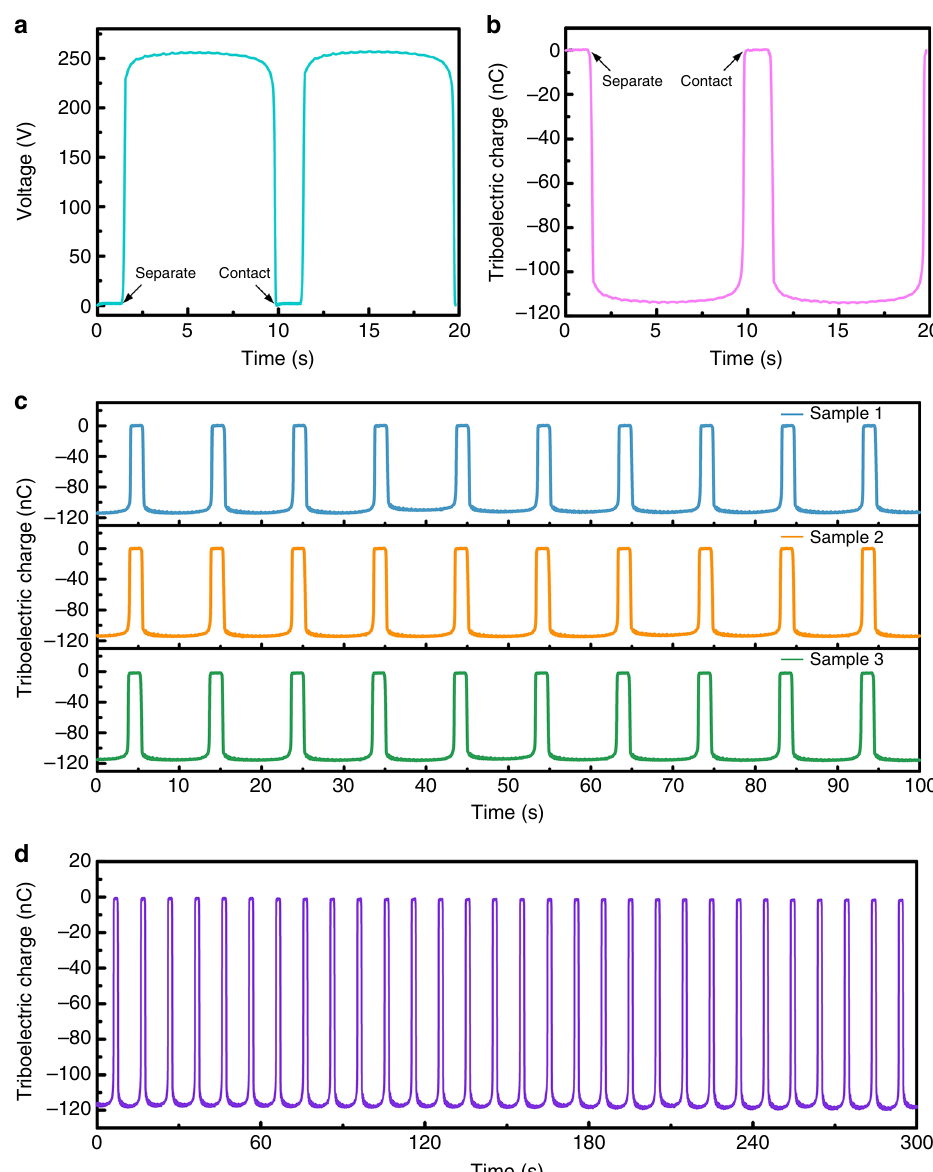
Fig. 3 Typical measured signals. a A typical output of open-circuit voltage in two cycles of contact and separation. b Short-circuit transferred charge between the two electrodes in two cycles. c The measured charge transferred for three samples for the same material of PTFE. d Stability of the measured value over a relatively long time-period for many